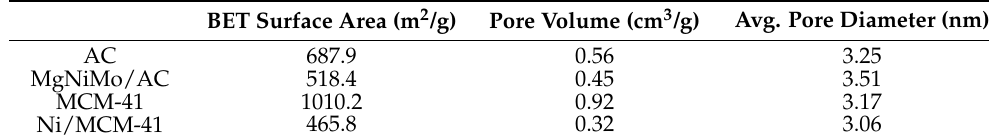
Table 3. Physical properties of catalysts.